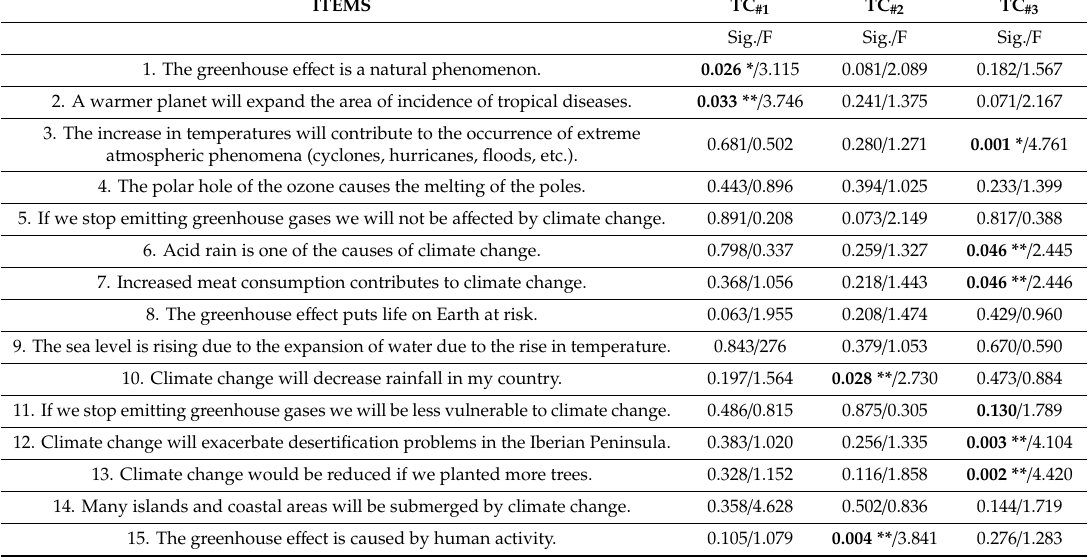
Table 12. To what extent do you feel informed about solutions to fight against